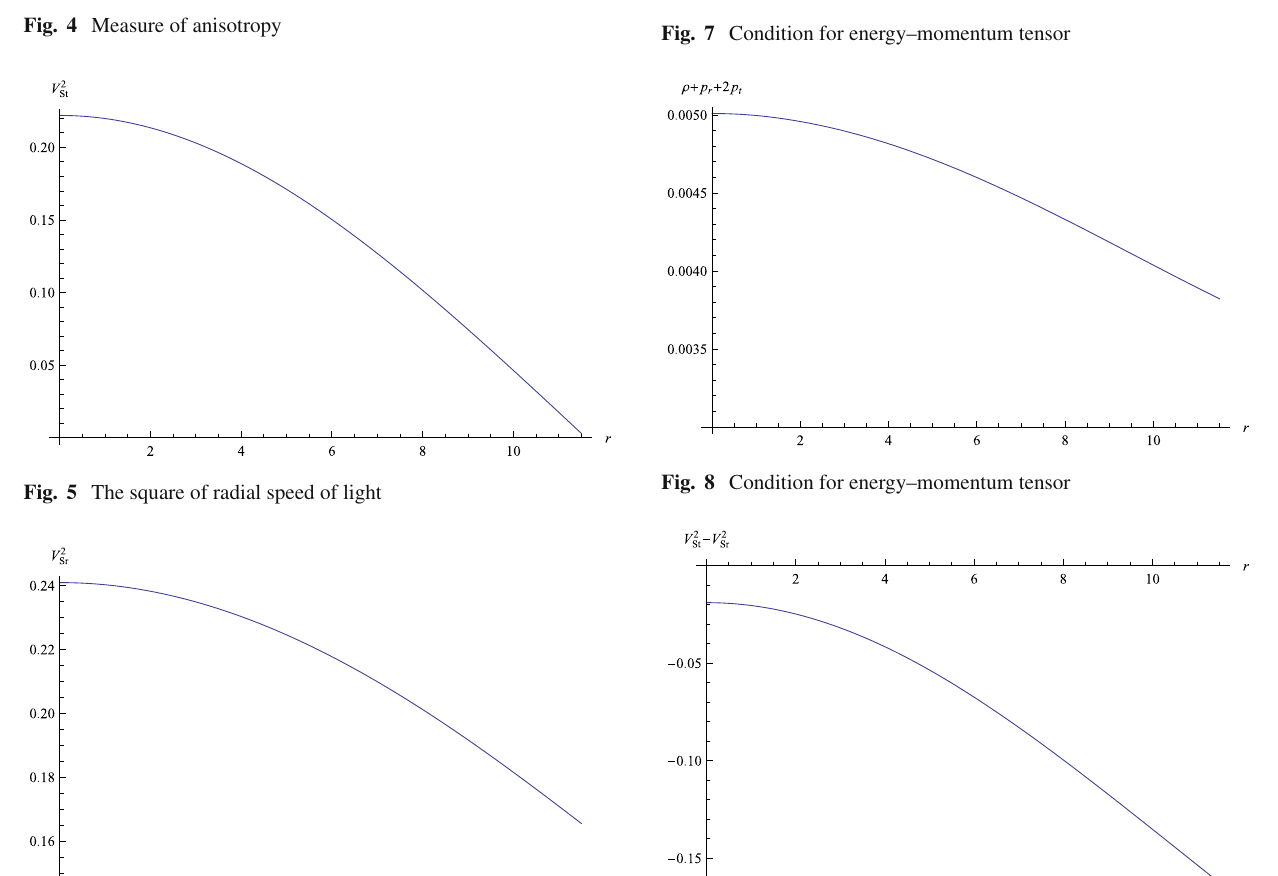
Fig. 4 Measure of anisotropy